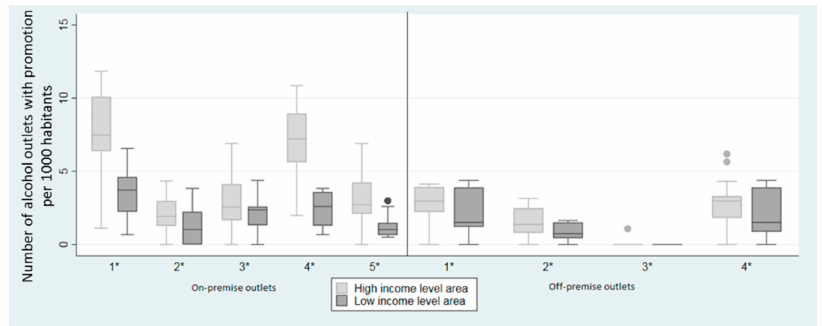
Figure 5. Distribution of the alcohol promotion according to the income level of the district in the city of Madrid, Spain, in 2018. It was measured as: (1) Number of (at least one) signs of alcohol promotion; (2) Number of alcohol outlets with the presence of advertisements; (3) Number of alcohol outlets with the presence of structural elements (awnings, labels, and / or specific alcohol beverage menu); (4) Number of alcohol outlets with alcohol products (alcohol bottles or cans) exhibited in shop windows and / or inside the venue visible from outdoors, and / or (5) alcohol outlets with the presence of furniture (i.e., barrels, alcohol boxes, tables, chairs, umbrellas, napkin holders, or ashtrays) associated with an alcohol brand. Furniture and terraces were recorded only in on-premise alcohol outlets. All the measures were expressed as the number of alcohol outlets with the presence of alcohol promotion element per 1000 inhabitants. * Significant di ff erences. p -value were estimated with a Wilcoxon test between high-income level area (leisure area) and low-income level area (residential area) with a level of confidence of